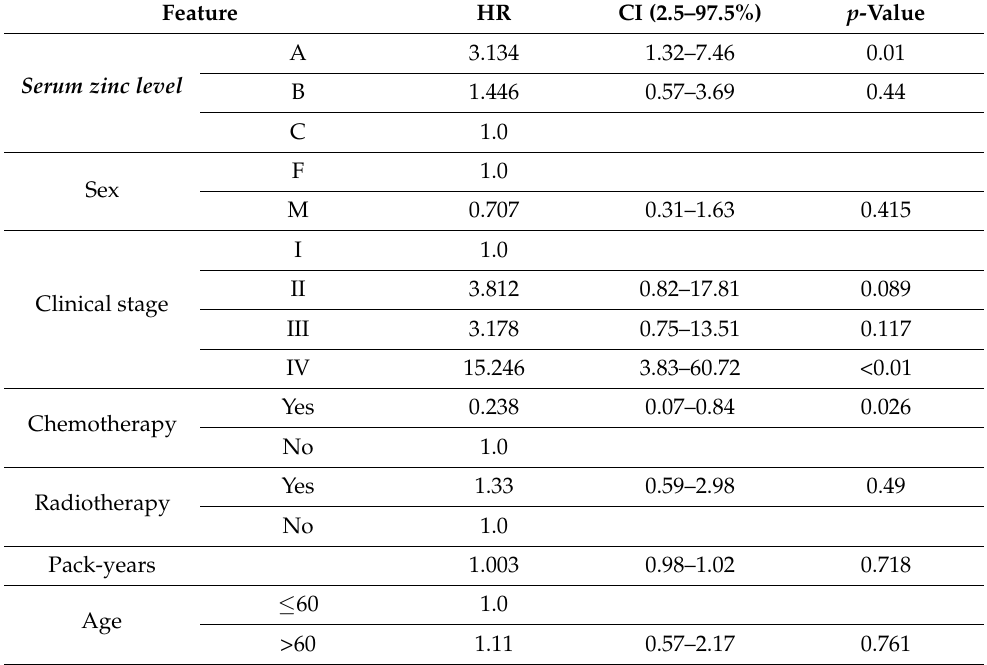
Table 8. Multivariable Cox regression ( SOD2 TC/TT and CAT CC , n = 121).